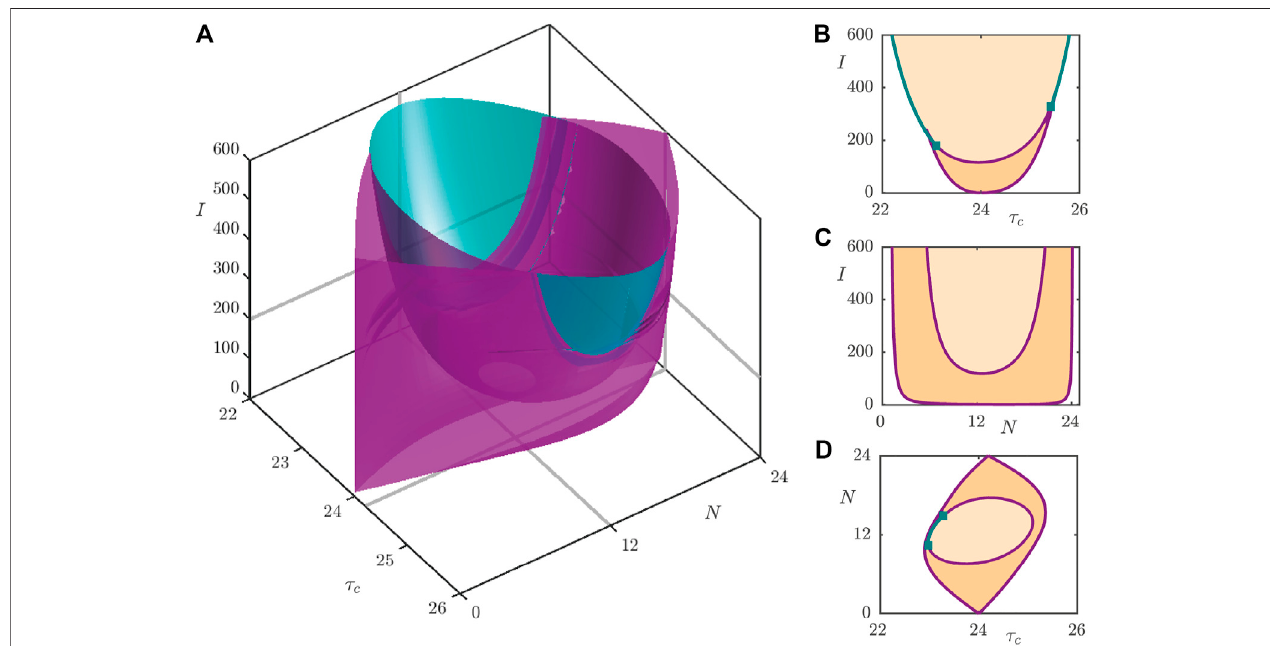
FIGURE 7 | (A) : Three-parameter bifurcation diagram of the 2D model under variation of ( I , N , τ c ) . (B – D) : Two-parameter bifurcation diagrams under variation of ( I , τ c ) for N (cid:1) 12 [panel (B) ]; ( I , N ) for τ c (cid:1) 24 . 2 [panel (C) ]; and ( N , τ c ) for I (cid:1) 200 [panel (D) ]. In all panels, purple lines/surfaces correspond to fold bifurcations, whereas teal lines/surfaces show Neimark – Sacker bifurcations. The square markers in panels (B) and (D) indicate the points at which the Neimark – Sacker and fold curves meet. In the orange shaded regions of panels (B – D) the stable, unstable and saddle periodic orbits exist; in the light orange shaded region only the stable periodic orbit exists. In the surrounding area (white), only the unstable periodic orbit exists and there is no entrainment to a 24 h